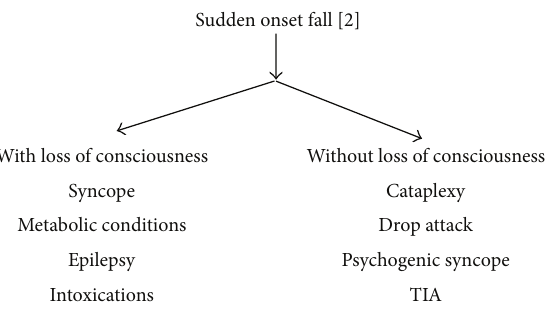
Figure 3: Causes of sudden onset